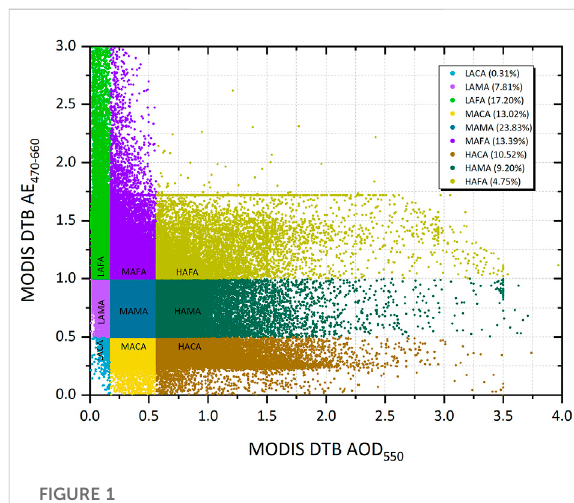
FIGURE 1 AEROSA generic classes using spatially distributed coincident Terra-MODIS DTB AOD 550 and AE 470-660 retrievals ( N = 180297) from March 2000 to February 2018. Where LACA: low-amount coarse-mode aerosols, LAMA: low-amount mixed-mode aerosols, LAFA: low-amount fi ne-mode aerosols; MACA: medium-amount coarse-mode aerosols, MAMA: medium- amount mixed-mode aerosols, MAFA: medium-amount fi ne- mode aerosols; and HCCA: high-amount coarse-mode aerosols, HAMA: high-amount mixed-mode aerosols, HAFA: high-amount fi ne-mode aerosols (see Table